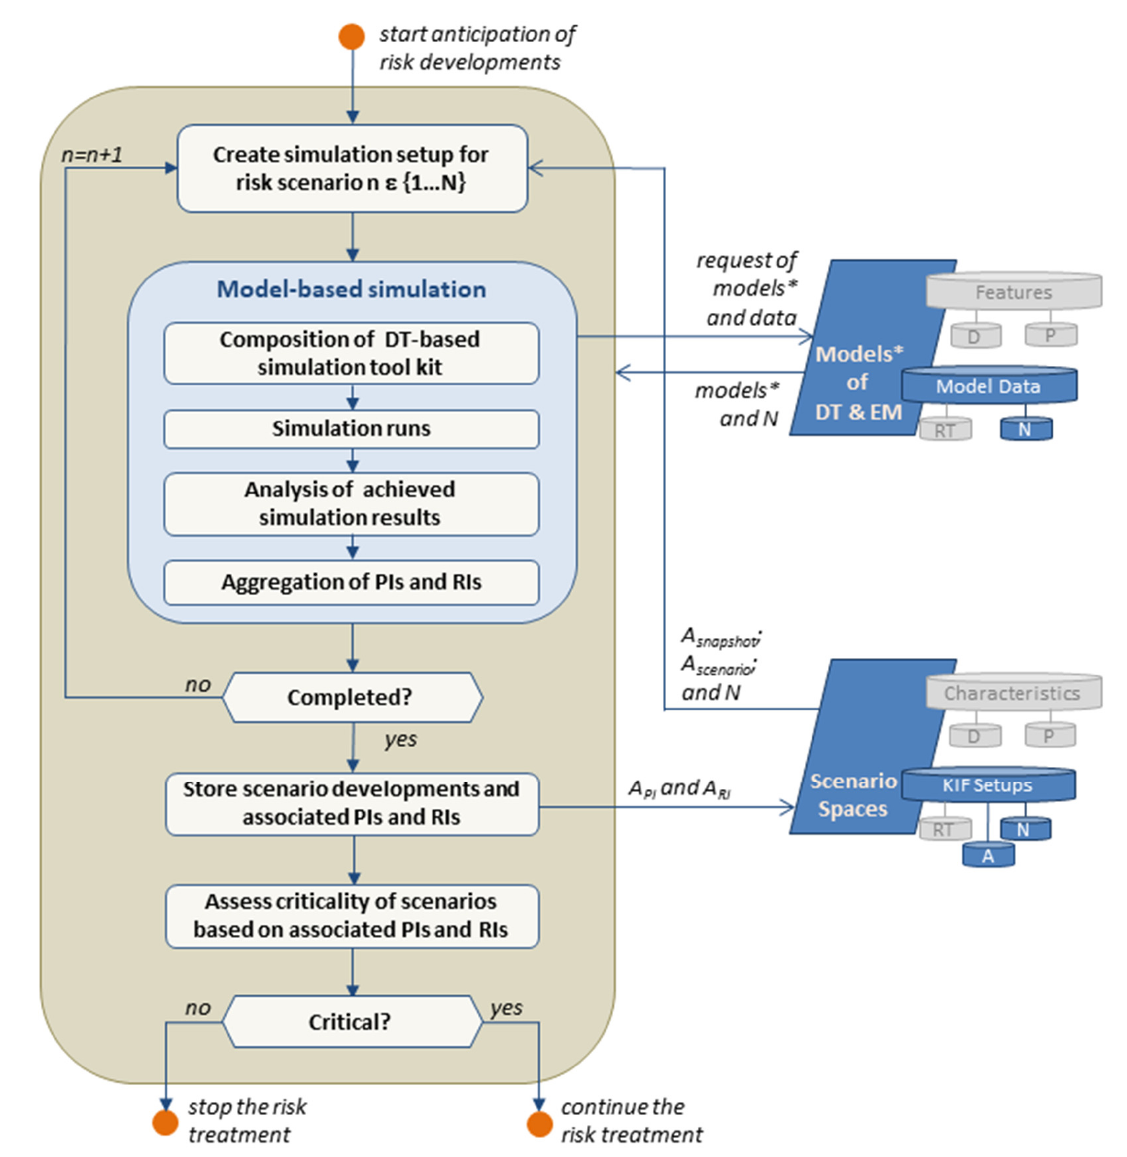
Figure 9. Flow chart of anticipation of risk developments.